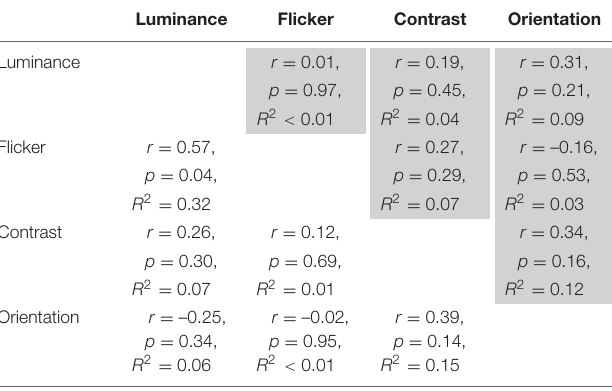
TABLE 1 | Inter-task Pearson correlation analyses on suppression index z- scores for the two groups separately (older =